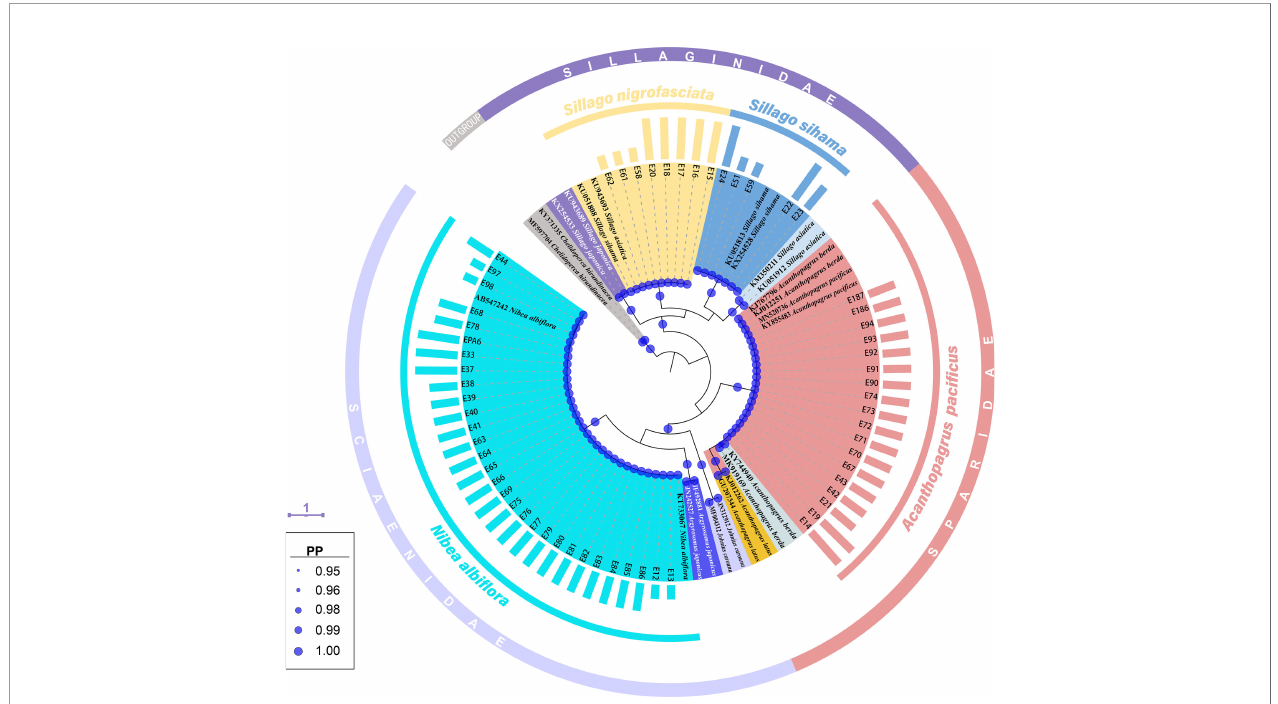
FIGURE 2 | A Bayesian inference (BI) tree based on COI gene of 61 egg sequences combined with 24 sequences downloaded from the GenBank. The fi nal alignments of 518 positions were used to construct this BI tree. The column bars have three sizes (short, medium, long) and represent three developmental stages (early, middle, late) respectively. The scale bar indicates the average number of nucleotide substitutions per site. Values of posterior probability (PP) >=0.95 are shown in